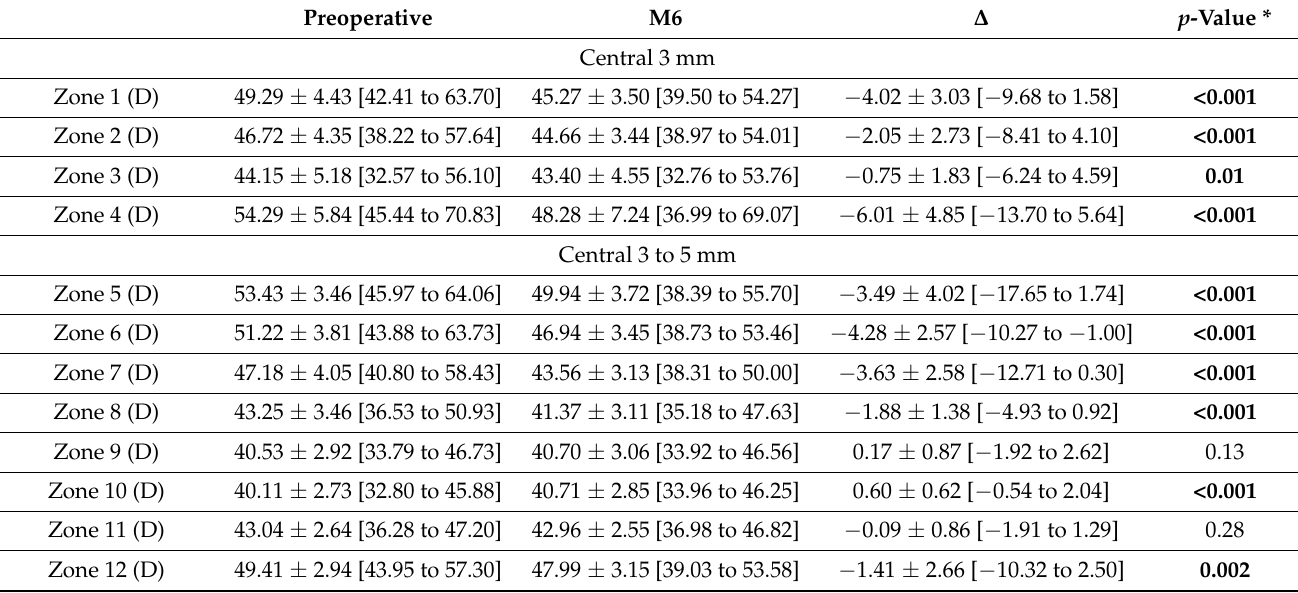
Table 3. Sagittal anterior keratometry in the central 8 mm ( n =